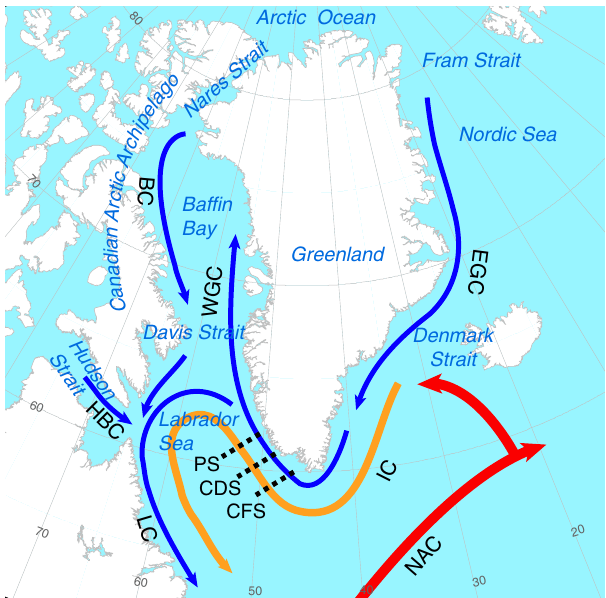
Figure 1 | Study region showing oceanographic sections and major currents around Greenland. Red and orange arrows indicate Atlantic-origin water and blue arrows indicate Arctic-origin water. BC, Baffin Current; CDS, Cape Desolation Section; CFS, Cape Farewell Section; EGC, East Greenland Current; HBC is Hudson’s Bay Current; IC, Irminger Current; LC, Labrador Current; NAC, North Atlantic Current; PS, Paamiut Section; WGC is West Greenland Current. Three-dimensional structure of major water masses in the Labrador Sea is shown in Supplementary Fig. 1.